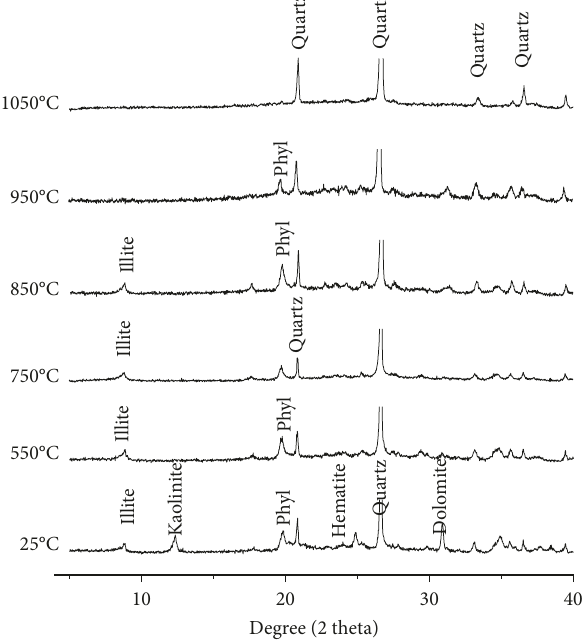
Figure 2: XRD patterns of Tunisian clay samples and thermally calcined samples. Phyl = phyllosilicate.